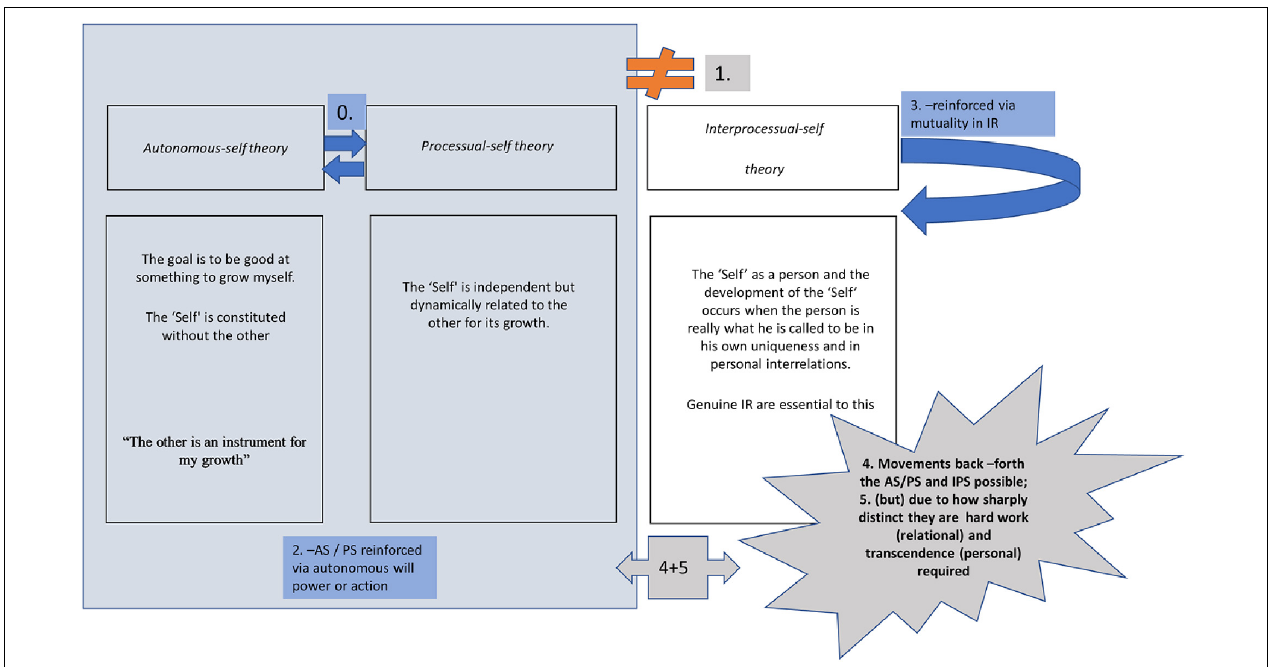
FIGURE 1 | Graphic diagram on autonomous-self theory, processual-self theory and Inter Processual-self theory. IR, interpersonal